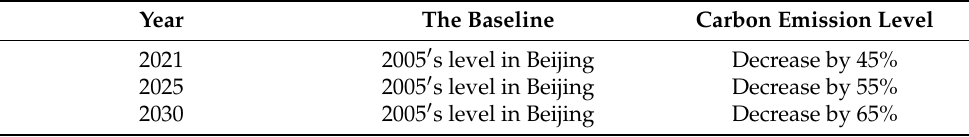
Table 3. The CO 2 emissions level in different planning periods [33].